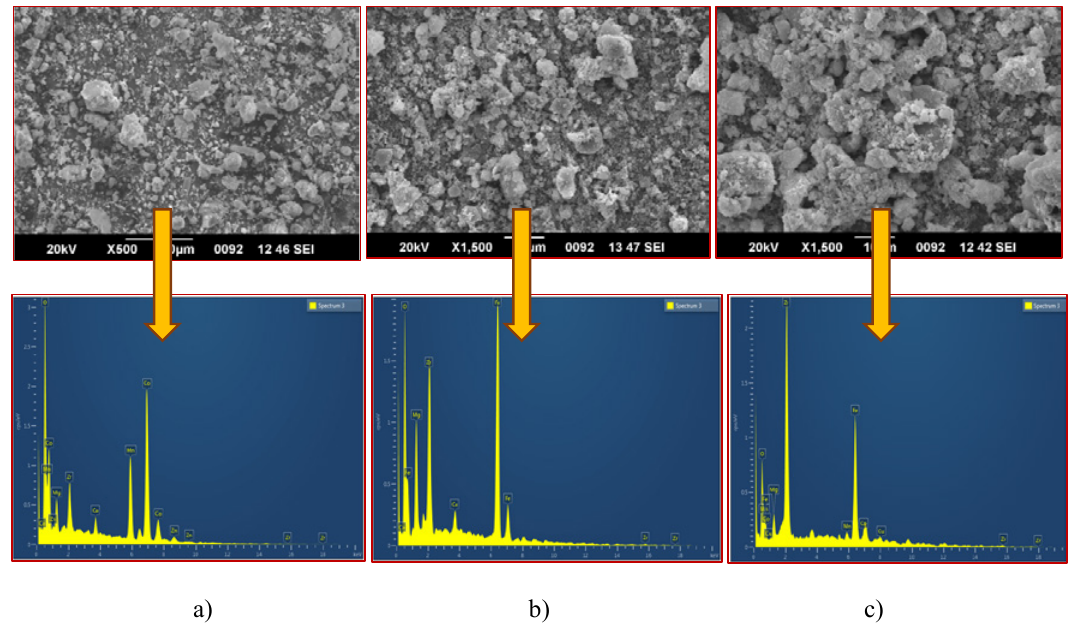
Fig. 3. SEM and EDAX analysis of a) MgZrO